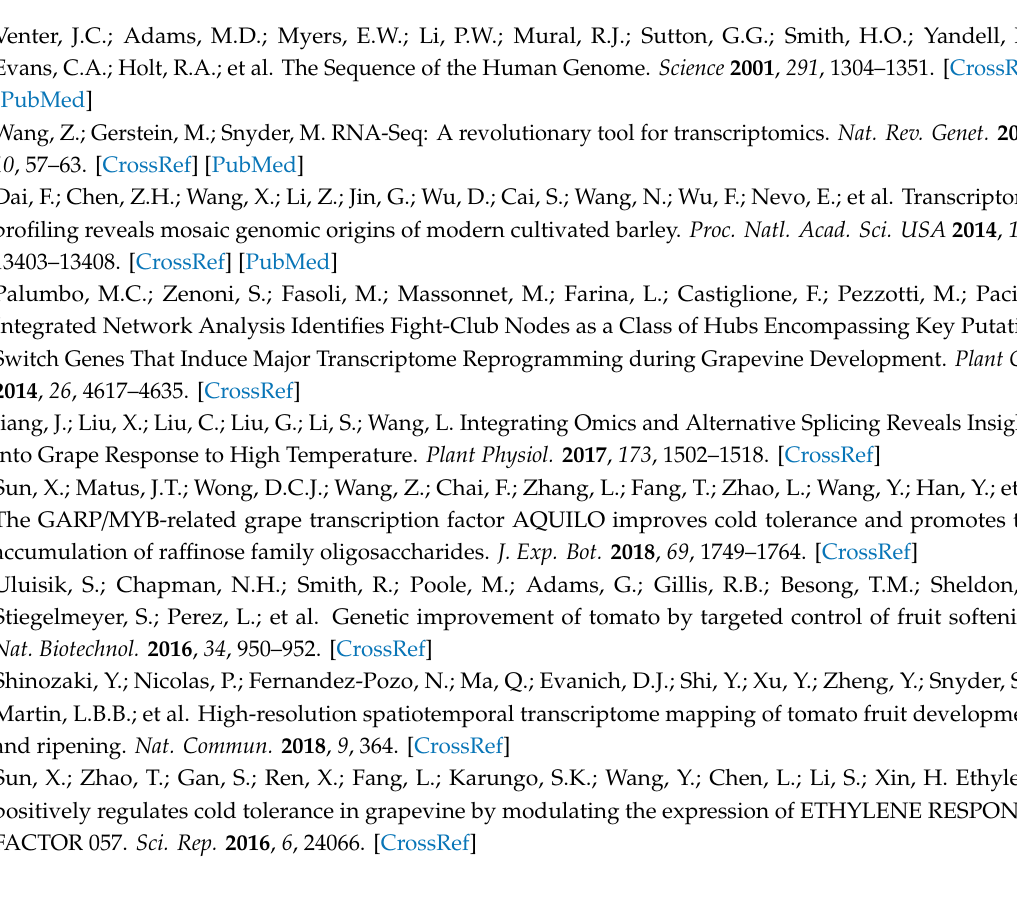
Table S1: Detailed information of all the RNA-seq samples used in the Grape-RNA